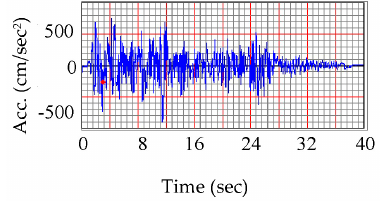
Figure 2. The El Centro earthquake accelerogram.